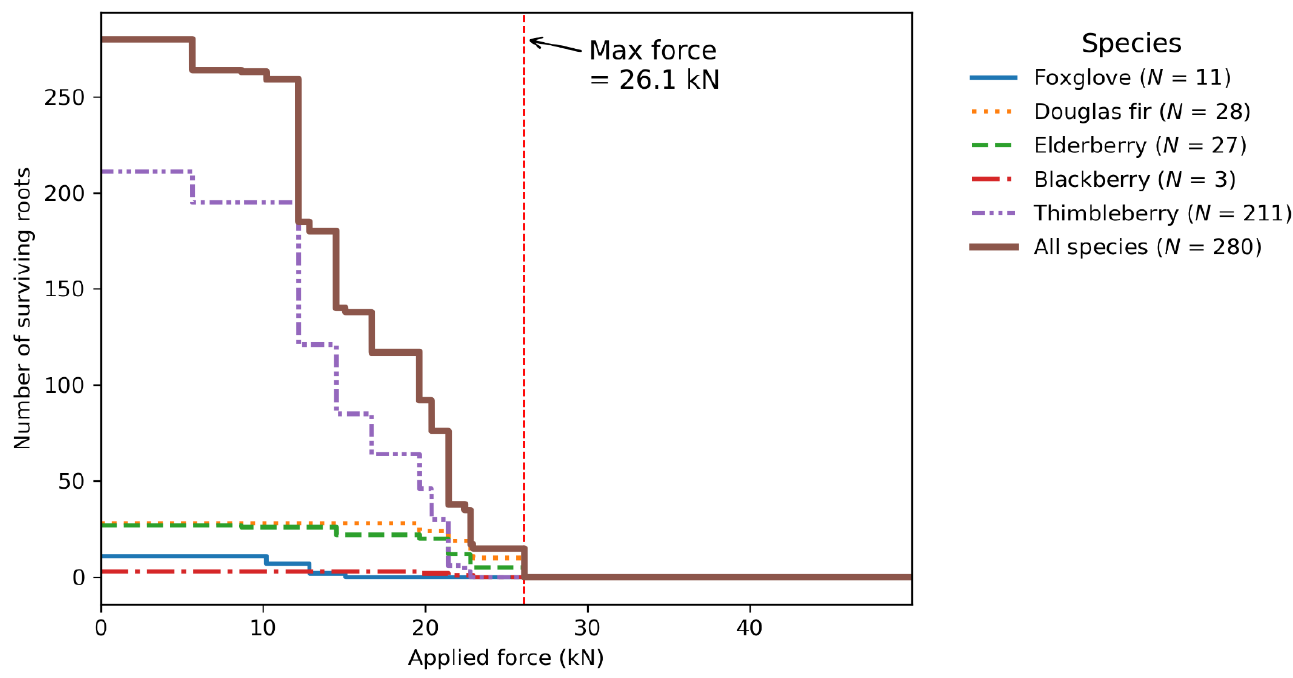
Figure 8. Results from the FBM, showing the number of surviving roots after application of different loads. Vertical dashed line indicates the maximum activated force.